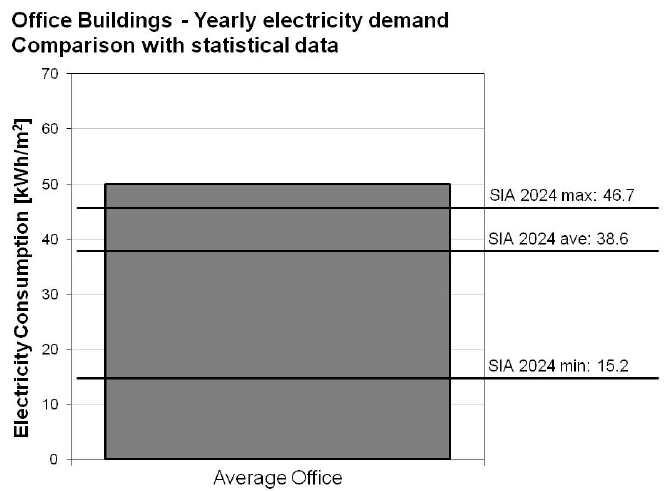
Figure 5. Comparison between the yearly electricity demands for office buildings elaborated on the basis of SIA 2024 [33] and the statistical data from Gruber et al. [29], in kW h/m 2